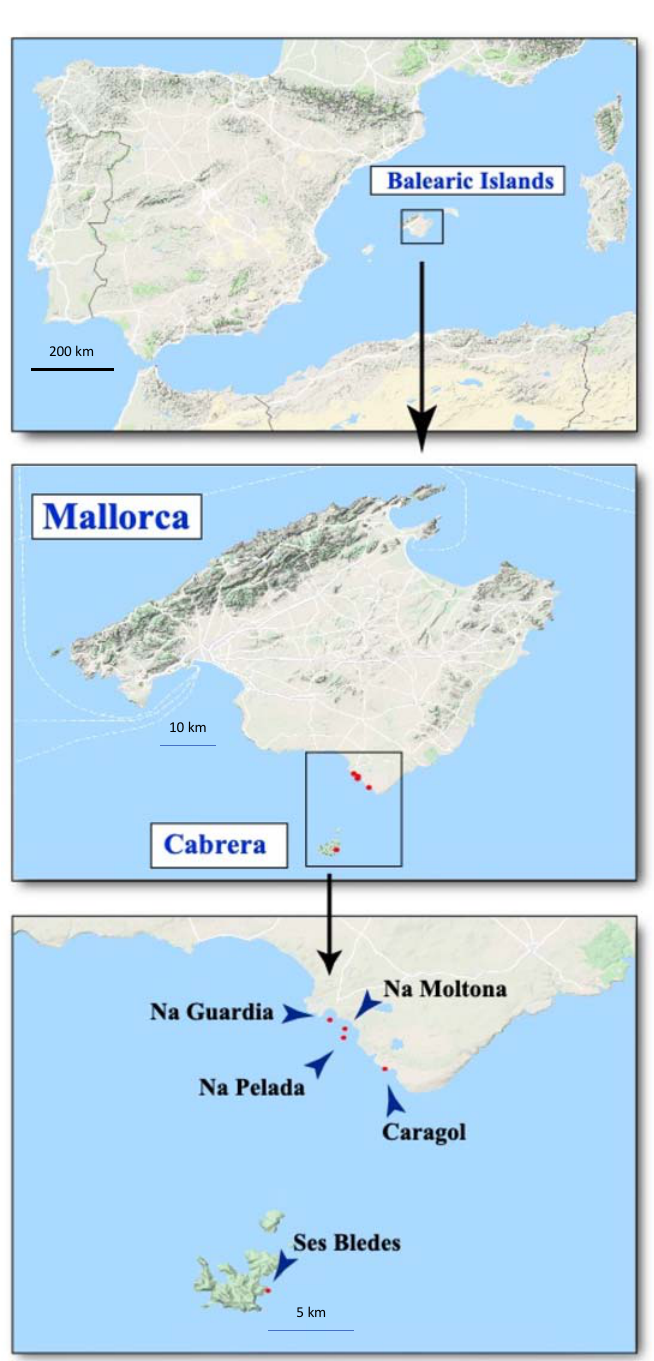
Figure 1. Maps of Mallorca and the Cabrera archipelago showing the location of the sampled Podarcis lilfordi (blue arrows). Maps were obtained with Google Maps (Map data 2020 Google) using the function ‘get_map’ in the package ‘ggmap’ version 3.0.0.902 in R version 3.6.3.